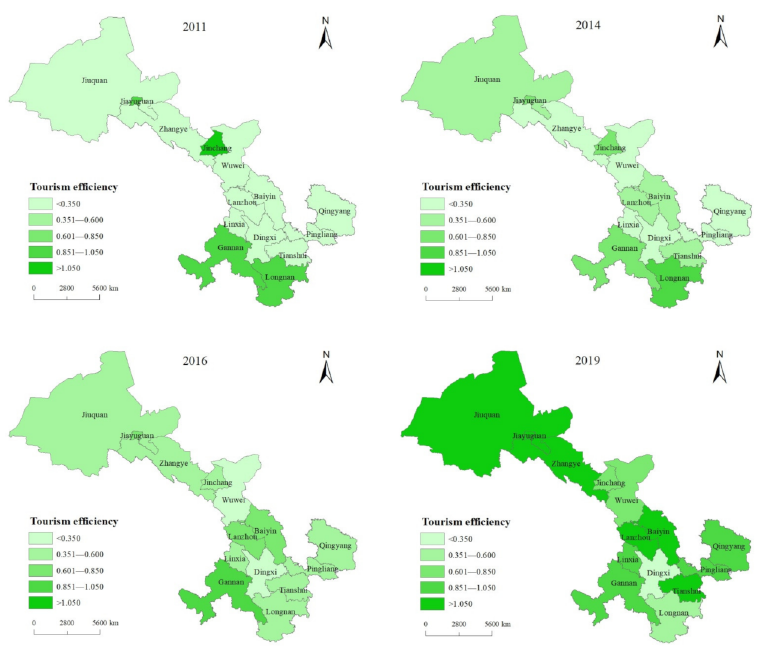
Figure 3. The spatial distribution of tourism efficiency in Gansu Province in 2011, 2014, 2016, and 2019.